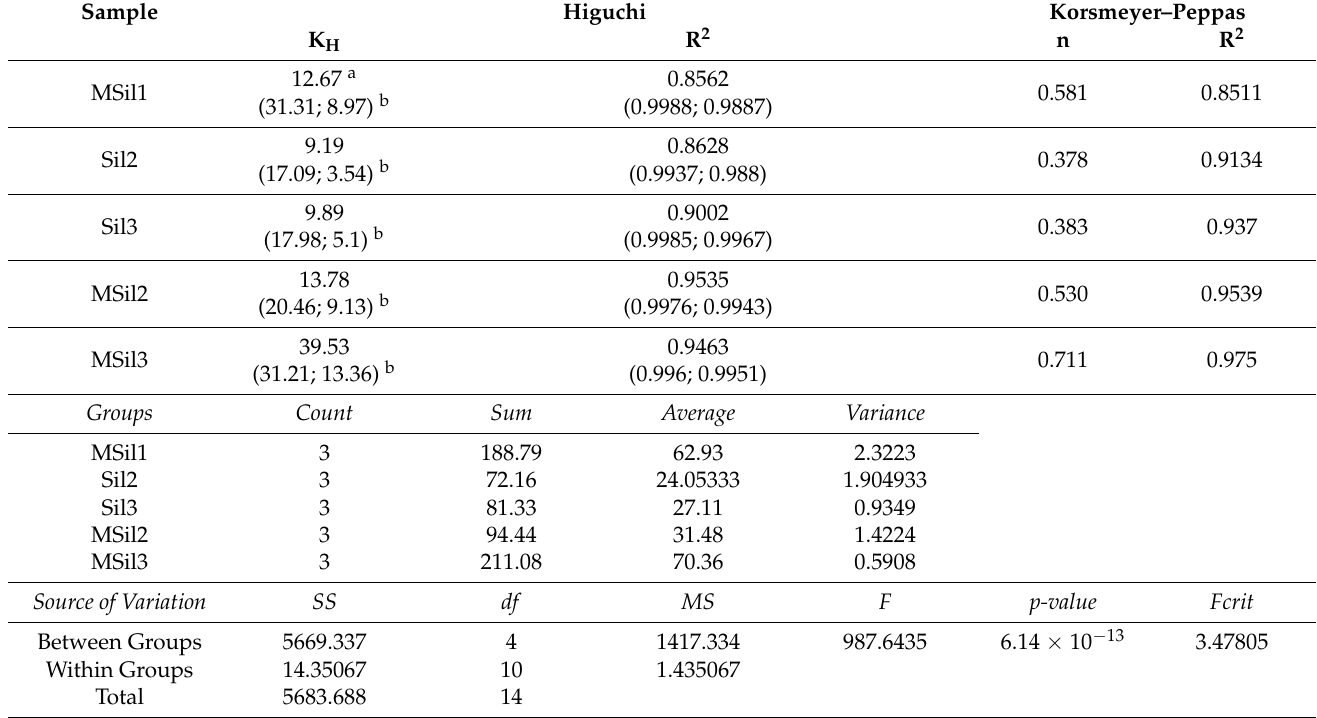
Table 6. Kinetic parameters of Dox Release and analysis of variance (ANOVA) at pH =